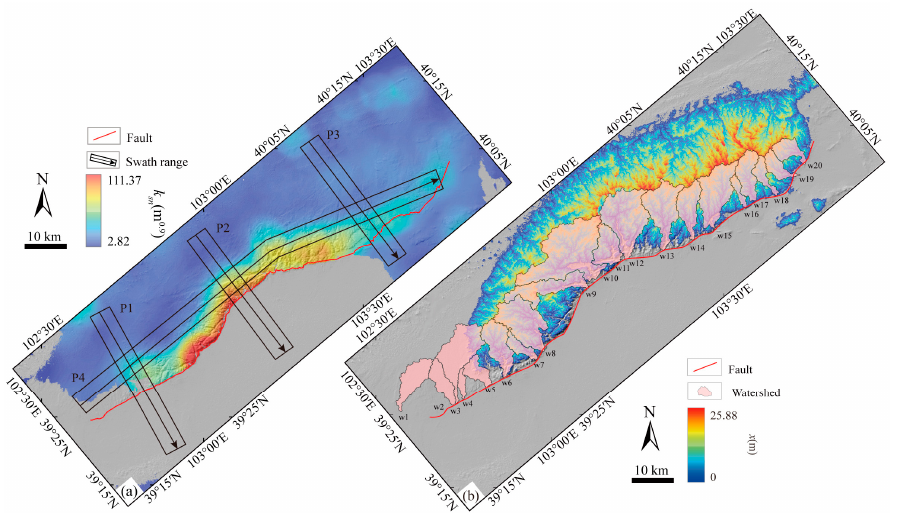
Figure 4. Distribution of geomorphic parameters in Yabrai Shan. ( a ) Channel steepness index and ( b ) χ . The black boxes in ( a ) indicate the swath profiles positions. The pink areas in ( b ) represent the watersheds used for the river longitudinal profiles .